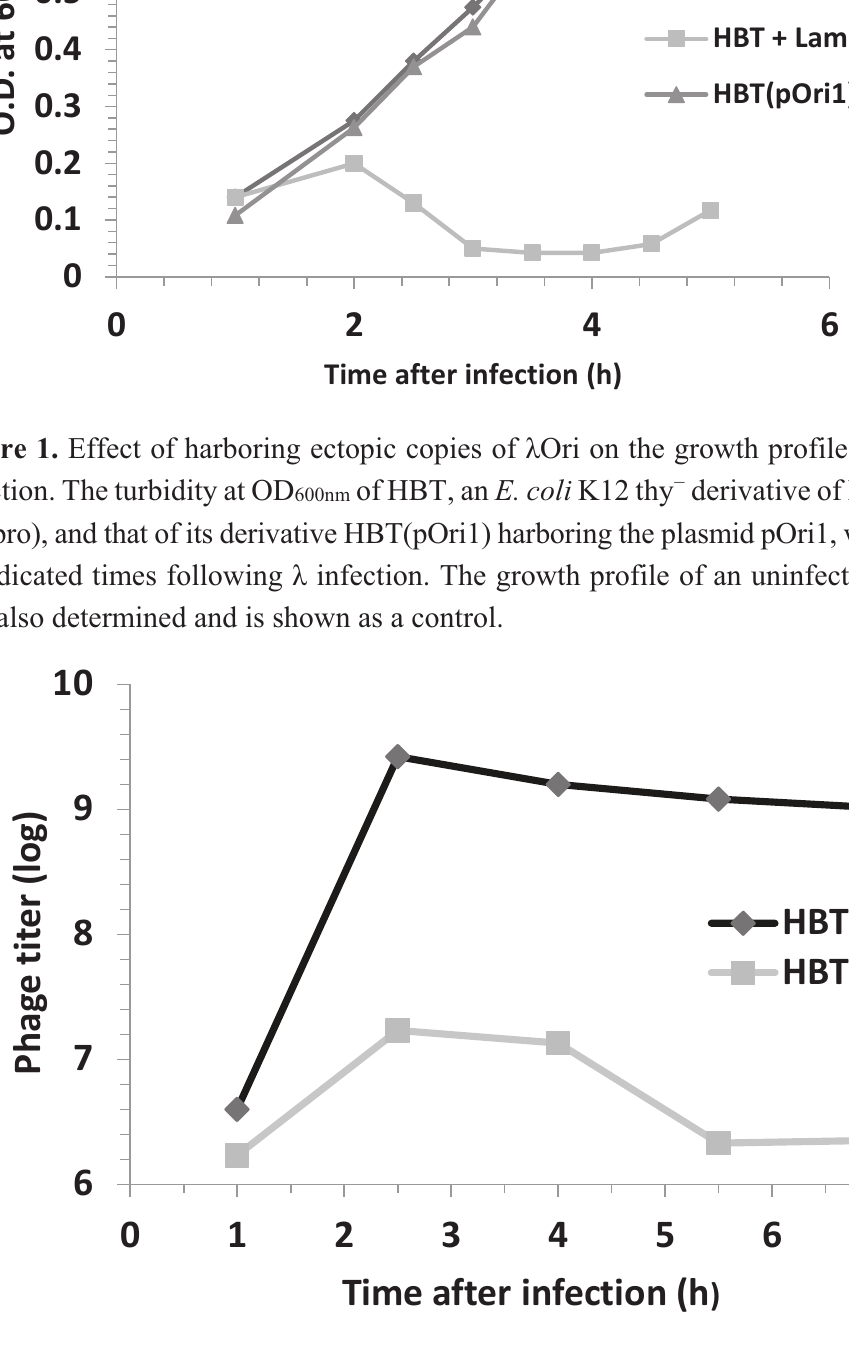
Figure 2. Phage titers following λ infection of HBT and HBT(pOri1). The phage titer from λ -infected cultures of HBT (pOri1) or HBT were determined at indicated times after infection, by plating dilutions of the culture unto plates containing sensitive bacteria HBT cells. Titers are expressed in a log